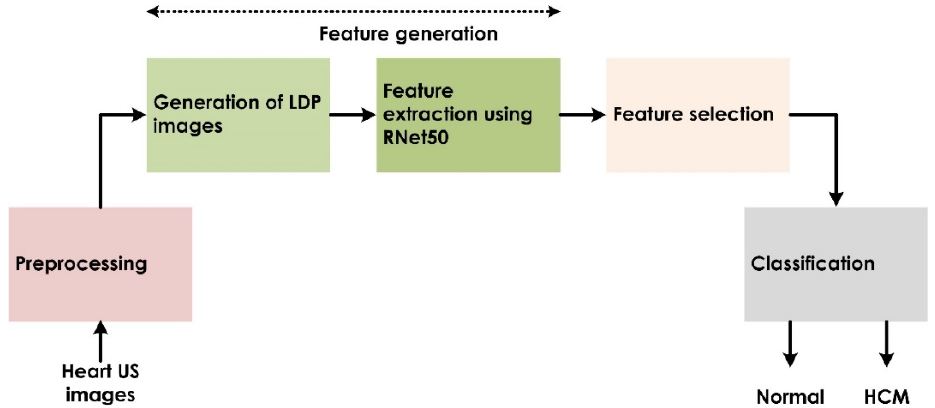
Figure 3. Schema of the deep-features-based proposed architecture.